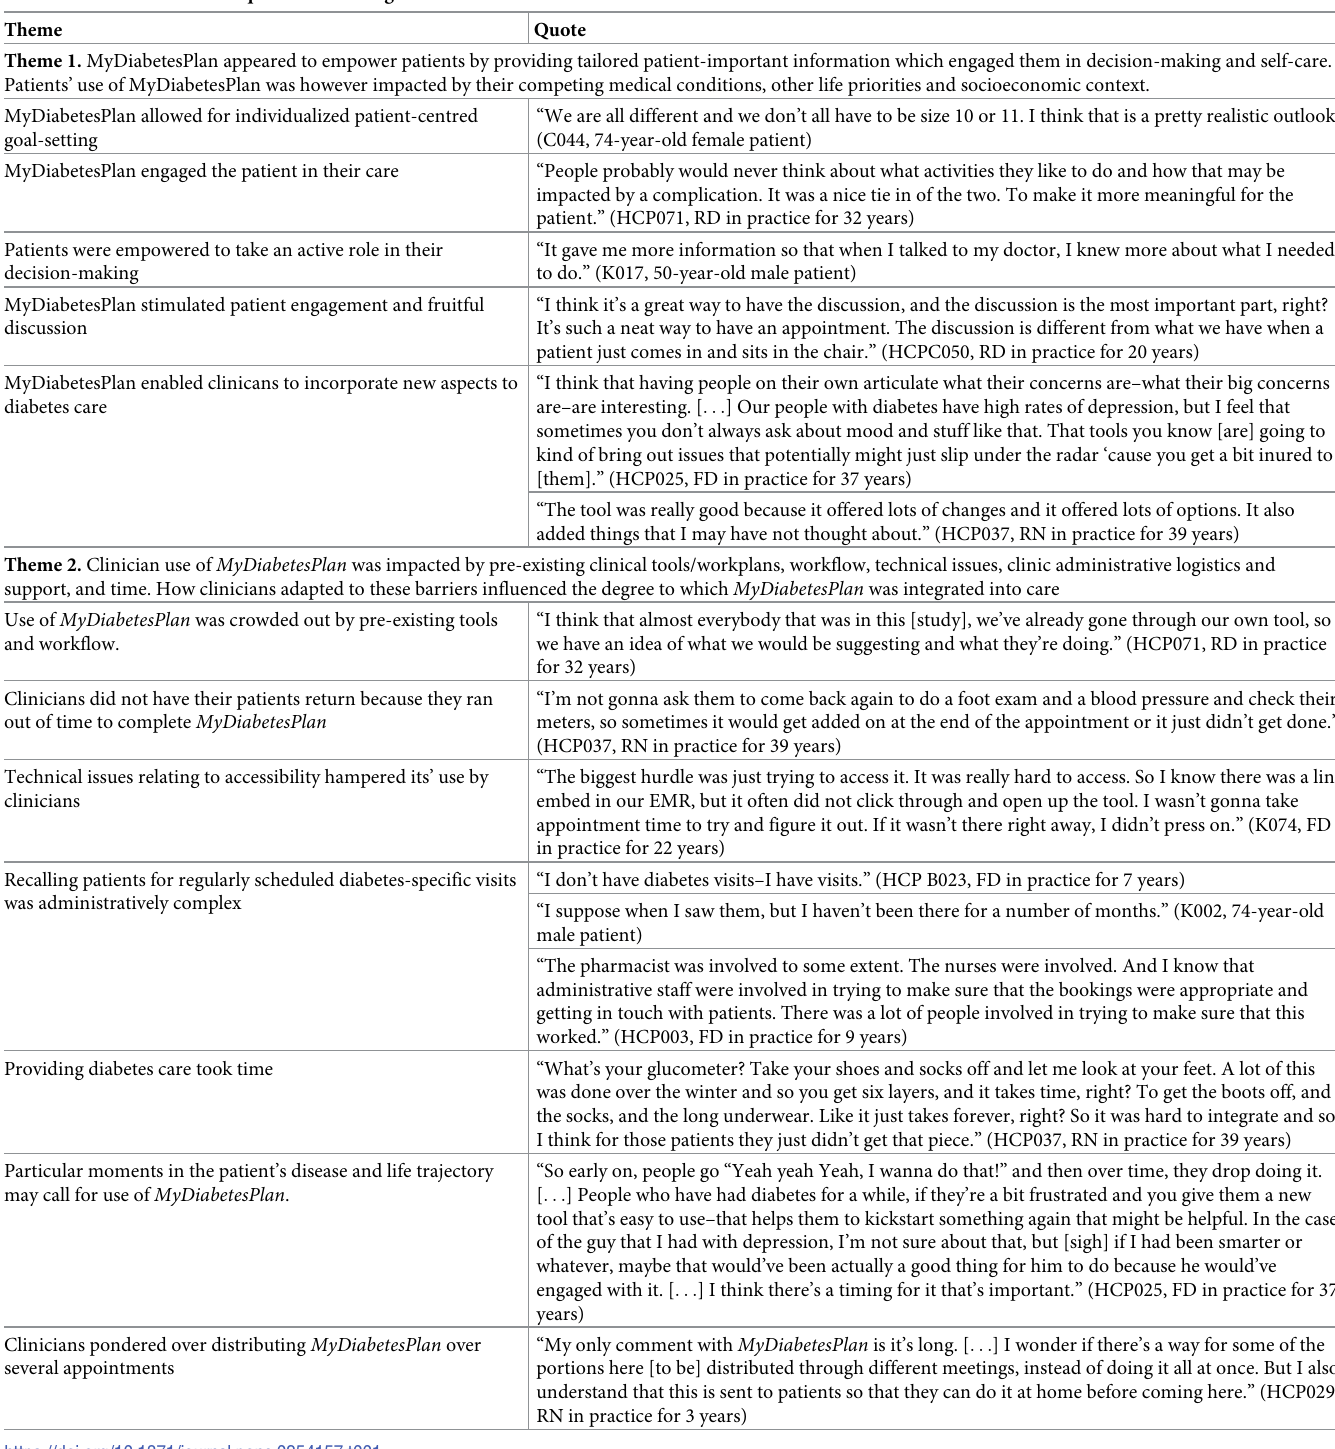
Table 1. Additional selected quotes illustrating